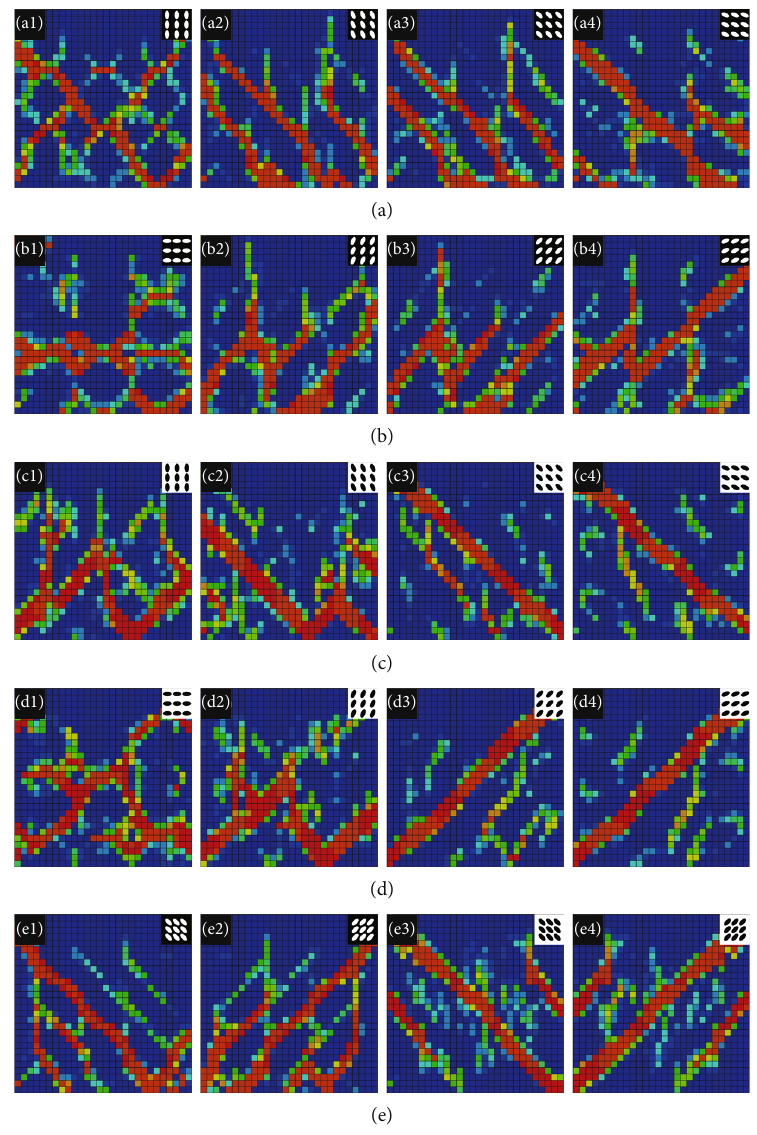
Figure 11: Compressive damage at the beginning of the residual stage ( ε = 0 : 01 ) of the structures with consistent inclusion inclination and grain size but di ff erent included angles and inclusion